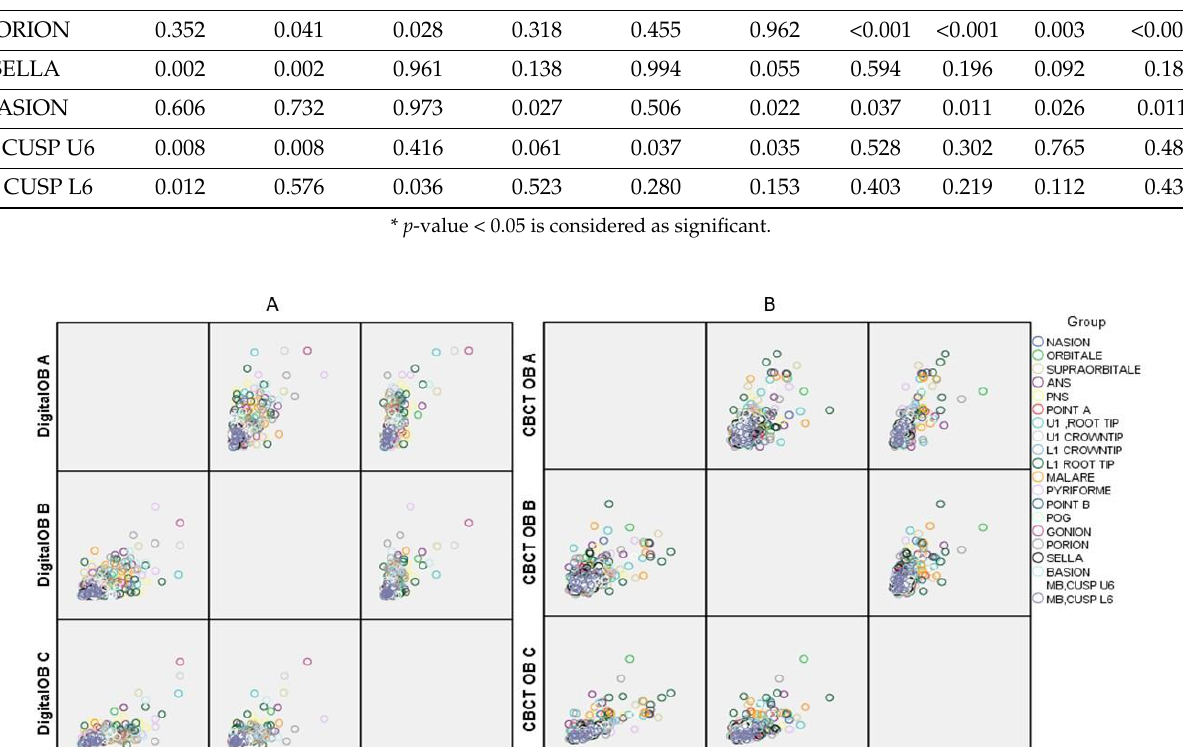
Figure 2. Inter-observer comparison of the plotting of the landmarks between the Digital and CBCT images. 4. Discussion Cleft lip and/or palate (CL ± P) malformations are the most common congenital ab- normalities in the craniofacial region and present a severe problem for health delivery systems throughout the world. Depending on the ethnicity and geographic location of the population, wide variations in the prevalence of cleft lip and palate have been reported, with higher rates amongst Asians and American Indians (one in 500 births). An isolated cleft palate is more frequently found in females than in males, at a ratio of 2:1. In contrast, there is a 2:1 male-to-female ratio for cleft lip with or without cleft palate [36].